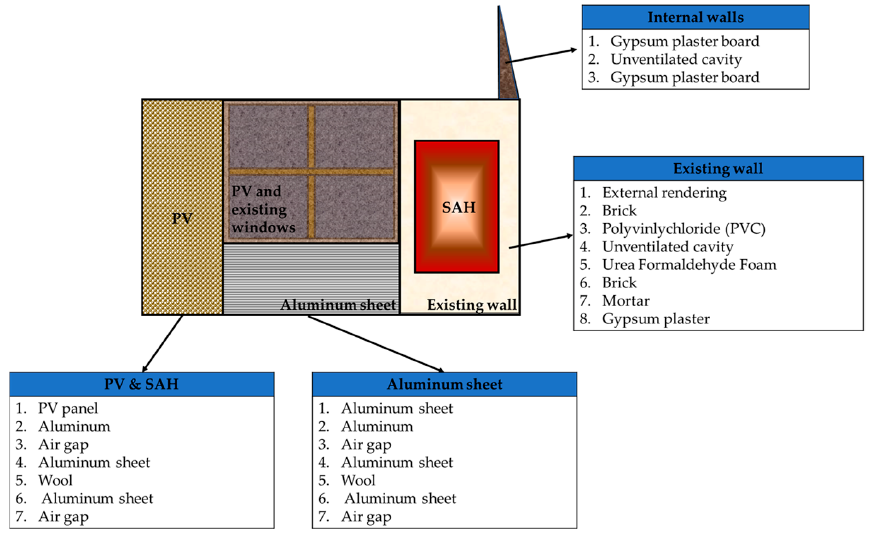
Figure 4. Formation of the Welsh ADBE system.